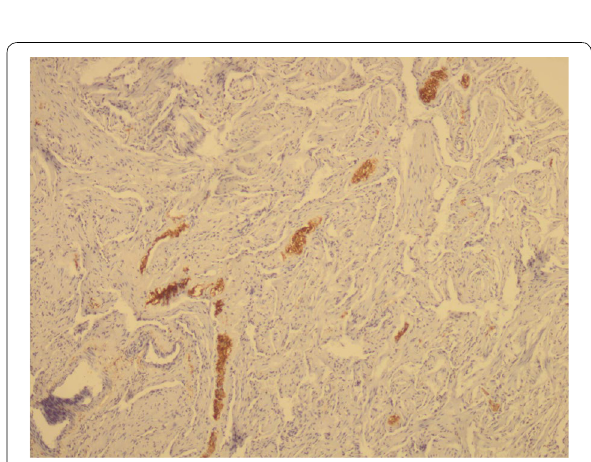
Fig. 5 S100 immunoreactivity in small nerve bundles on the dorsal surface ( ×